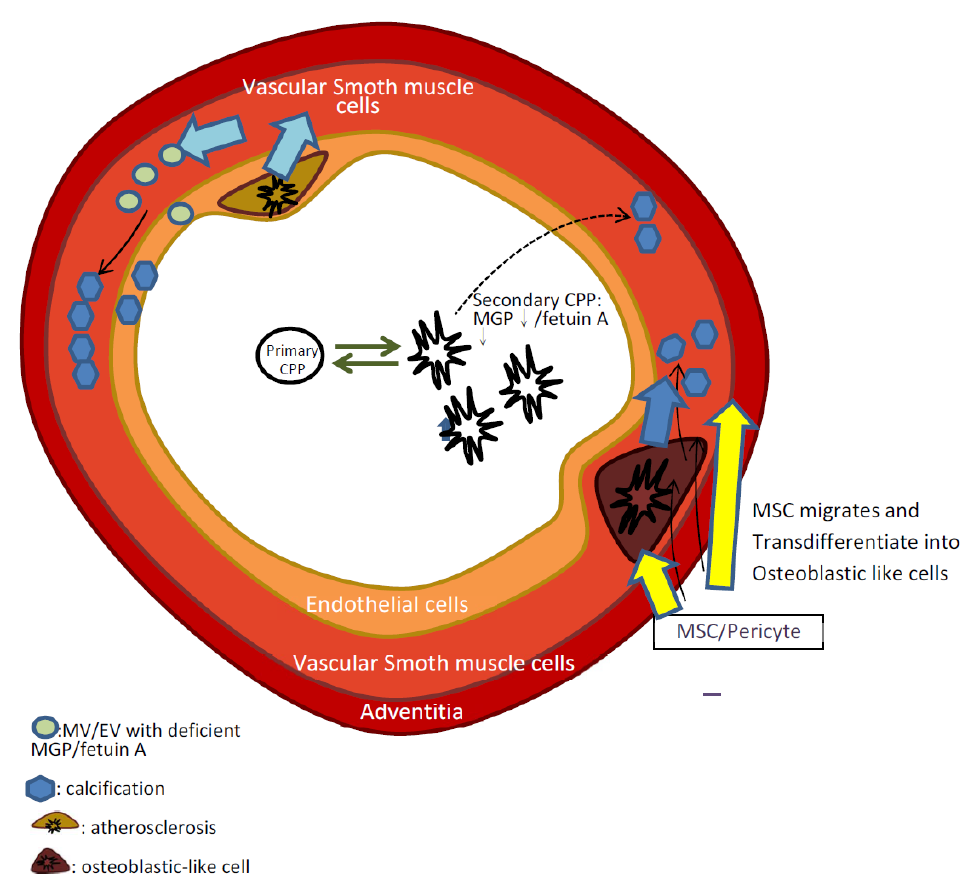
Figure 1. The mechanism of the vascular calcification based on endothelial injury, vascular smooth muscle cell (VSMC) calcification, mesenchymal stem cells (MSCs)/pericytes in the adventitial layer, and the deficiency of calcification inhibitors. Cells from all layers of the vessel wall transformed into osteoblast-like cells. The atherosclerosis within the endothelium induced endothelial calcification by releasing matrix vesicles (MV)/extracellular vesicles (EV) with insufficient matrix Gla protein (MGP)/fetuin A. On the other hand, atherosclerosis also stimulated VSMCs to release MV/EV with insufficient fetuin A after being injured by uremic toxin or renin – angiotensin – aldosterone system (RAAS) activation. The adventitial MSCs/pericyte migrated to the medial layer and transdifferentiated into osteoblast-like cells, which contributed to calcification of the medial layer. CPP: calciprotein particle.